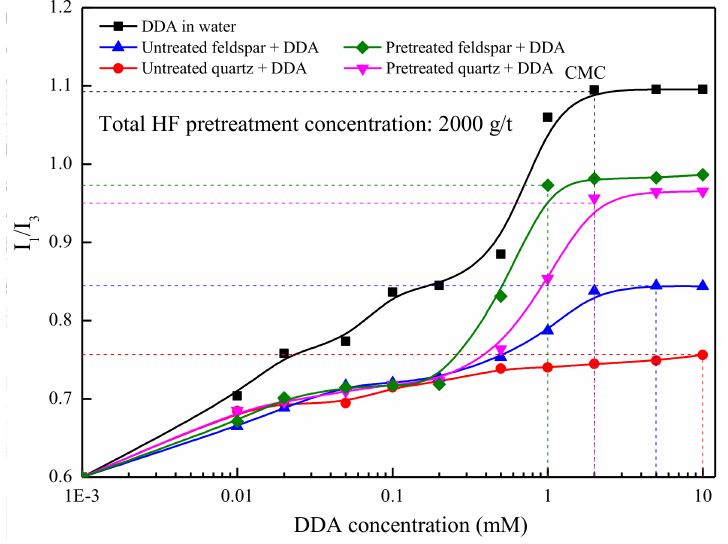
Figure 5. Values of I 3 / I 1 on feldspar and quartz surface as a function of DDA concentration and HF